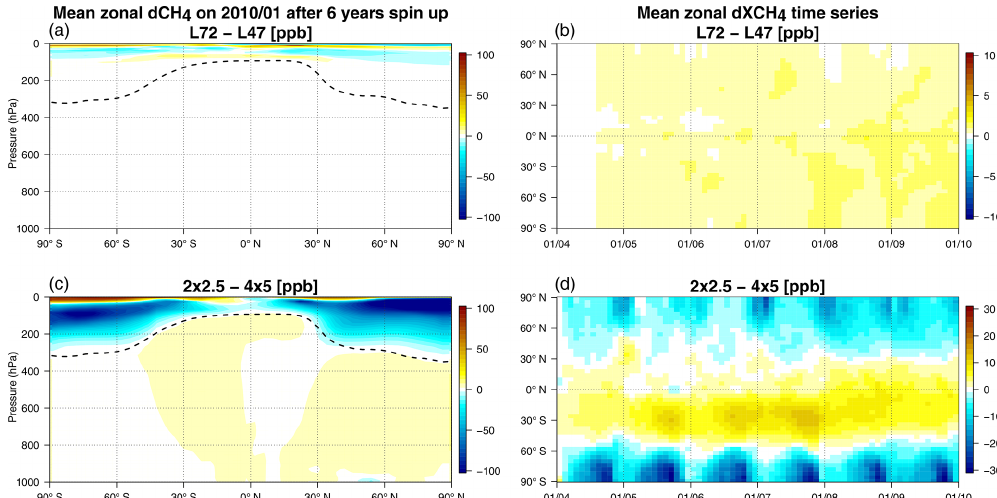
Figure 9. (a, b) Differences in CH 4 between the GEOS-Chem simulations with 72 and 47 vertical levels. (c, d) Differences in CH 4 between the GEOS-Chem simulations at 2 ◦ × 2 . 5 ◦ and 4 ◦ × 5 ◦ . (a, c) The zonal mean CH 4 difference after 6 years of simulation. (d, e) The zonal mean XCH 4 bias time series obtained by smoothing the CH 4 difference profiles with mean latitudinal GOSAT averaging